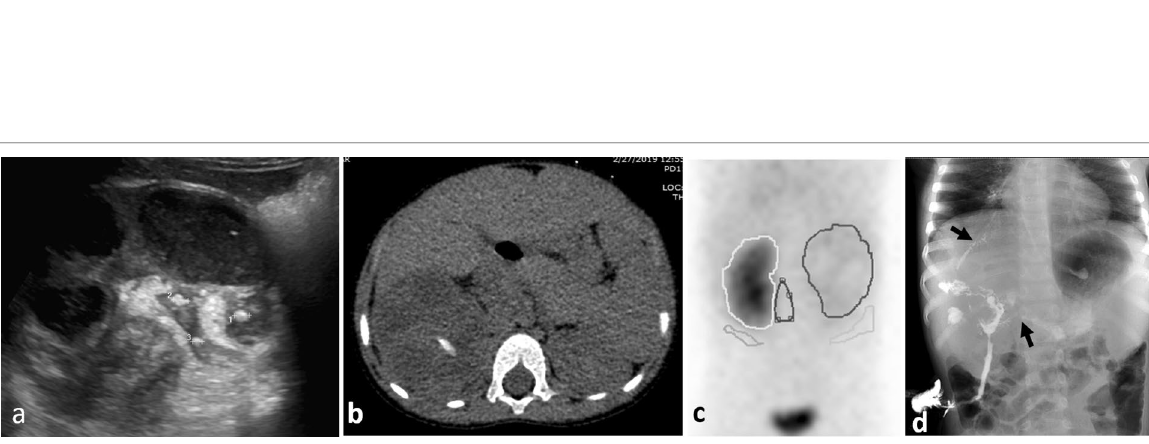
Fig. 14 3-year-old girl with history of recurrent urinary tract infection and right loin pain and diagnosed as Xanthogranulomatous pyelonephritis with fistulous communication to the airway and duodenum. a Ultrasound reveals distorted renal parenchyma with multiple echogenic stones with paradoxically contracted renal pelvis. b Axial non-contrast CT reveals enlarged right kidney with multiple necrotic areas and a central stone. The inflammatory process extends to the perinephric region and right psoas muscle. c DTPA scintigraphy reveals normal uptake in the normal left kidney and no uptake in the right kidney. d Fistulography through a cutaneous opening reveals multiple fistulous tracts communicating with the bronchial tree, and duodenum